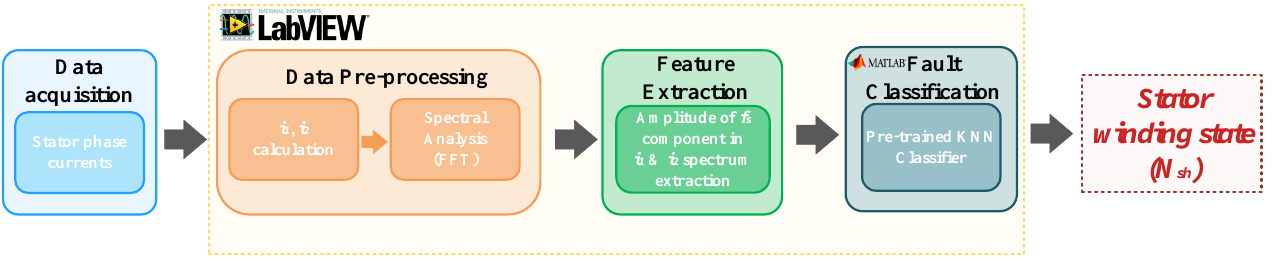
Figure 13. Flowchart of the proposed on-line fault classification algorithm. The first on-line verification scenario (Test 1) was carried out for motor operation in such conditions for which the model of the KNN classifier was trained, i.e., T L = (0 ÷ 1) T N with a 0.2 T N step and f s = f sN = 100 Hz. In this scenario, one, two and three turns were short circuited for several seconds. This is referred to hereinafter as steady short circuits. The efficiency of the classifier C EFF for this condition was as high as 99.4%. The classifier responses and the actual states of the stator winding during this scenario are shown in Figure